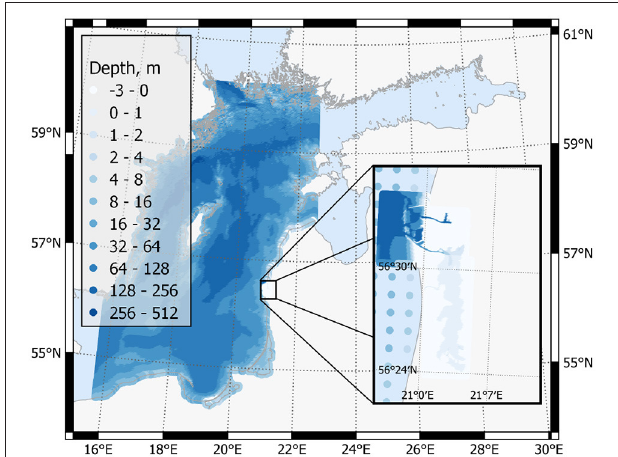
FIGURE 1 | Nested domains of Baltic sea—Liepaja port—Liepaja lake setup.